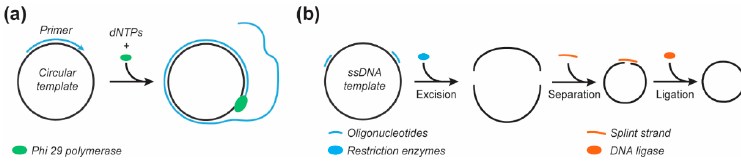
Figure 5. Alternative enzymatic methods for ssDNA scaffold production. ( a ) Rolling circle amplification. ( b ) Excision and circularization of a ‘mini’ scaffold from the M13mp18 genome.